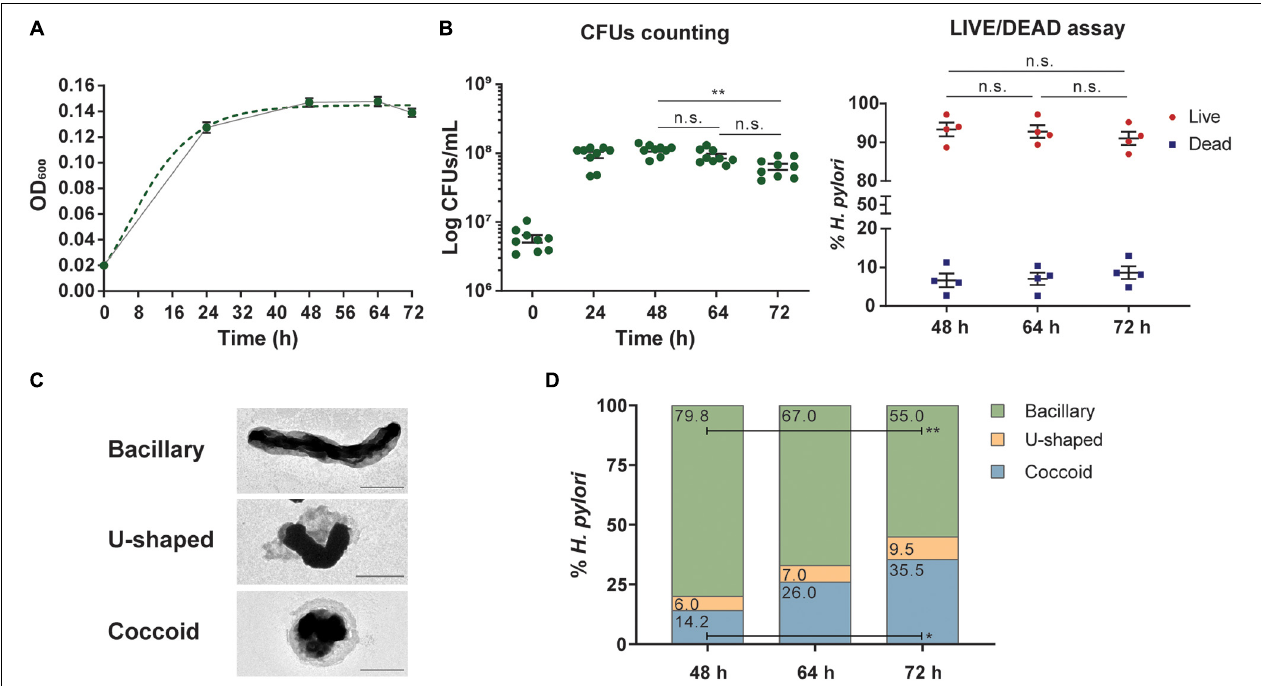
FIGURE 1 | Kinetics, viability, and morphology of Helicobacter pylori growth in liquid F-12-cholesterol. (A) Growth curve of Helicobacter pylori 26695 grown in F12 liquid medium supplemented with 1 × cholesterol (continuous line), modeled using the Gompertz growth equation model (dotted line), calculated with GraphPad Prism, and based on the optical density measurements of the bacterial suspension at 600 nm (OD 600 ) from 24, 48, 64, and 72 h cultures. Data are shown as mean ± SEM of 16 biological replicates. (B) Bacterial viability evaluated by colony-forming units (CFUs) counting (left graph) and the LIVE/DEAD BacLight Bacterial Viability assay (right graph). The number of CFUs was determined at the referred time points, represented as CFUs/mL. Each dot represents a biological replicate ( n = 9) and data are shown as mean ± SEM. Statistical significance was evaluated using the one-way ANOVA with post hoc Tukey’s test, comparing all datasets with each other; only comparisons between 48, 64, and 72 h were illustrated for the sake of simplicity; ** p ≤ 0.01, n.s. – not significant. LIVE/DEAD BacLight Bacterial Viability assay at 48, 64, and 72 h of growth, by flow cytometry. After sample staining with SYTO9 and PI dies and acquisition on a FACSCanto II cytometer, live and dead bacteria were gated and defined as SYTO9 + PI − and SYTO9 + PI + , respectively. Each dot represents a biological replicate ( n = 4) and data are shown as mean ± SEM of the frequency of gated SYTO9 + PI − and SYTO9 + PI + bacteria. Statistical significance was evaluated using the two-way ANOVA with post hoc Tukey’s test; n.s. – not significant. (C) Representative negative stain TEM micrographs of bacillary, U-shaped, and coccoid forms of H. pylori from a 64 h liquid culture. Scale bars: 1 µ m; 80,000 × (bacillary and coccoid) and 8,000 × (U-shaped) original magnifications. (D) Quantification of bacillary, U-shaped, and coccoid forms of H. pylori present in F12-cholesterol liquid cultures at 48, 64, and 72 h from negative stained TEM micrographs, using manual counting. The frequency of each bacterial form was calculated considering the total number of bacteria (741, 1,215, and 1,061) counted in micrographs taken from samples of each time point, 48 h ( n = 5), 64 h ( n = 5), and 72 h ( n = 2), respectively. The mean frequency of each form is displayed inside the respective bar. Statistical significance was evaluated using the two-way ANOVA with post hoc Tukey’s test, comparing all datasets with each other; statistical significance was only observed between 72 and 48 h for bacillary and coccoid forms; * p ≤ 0.05 and ** p ≤